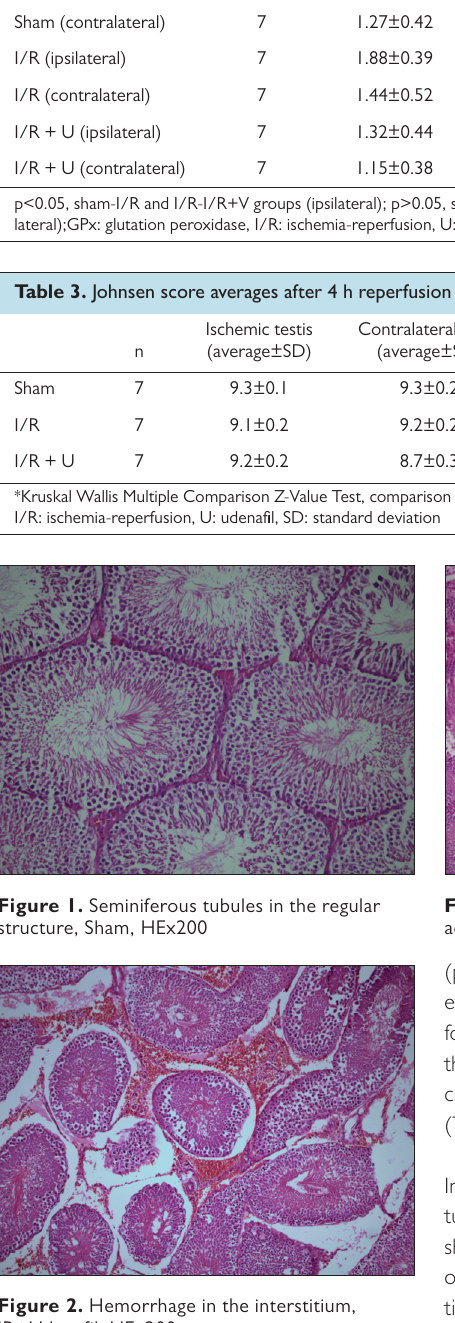
Extent Intensity